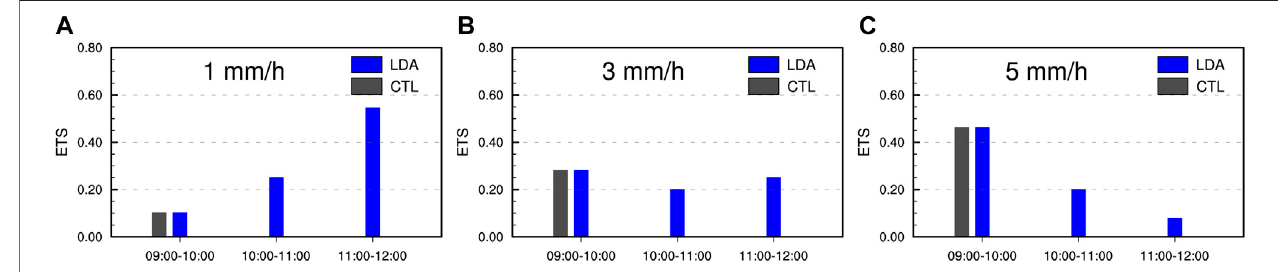
FIGURE5| Comparisonofequitablethreatscore(ETS)forhourlyprecipitationbetweendifferentexperimentatthethresholdof (A) 1 mm, (B) 3 mm,and (C) 5 mm. The gray and blue bars indicate control experiment and assimilation experiment, respectively.